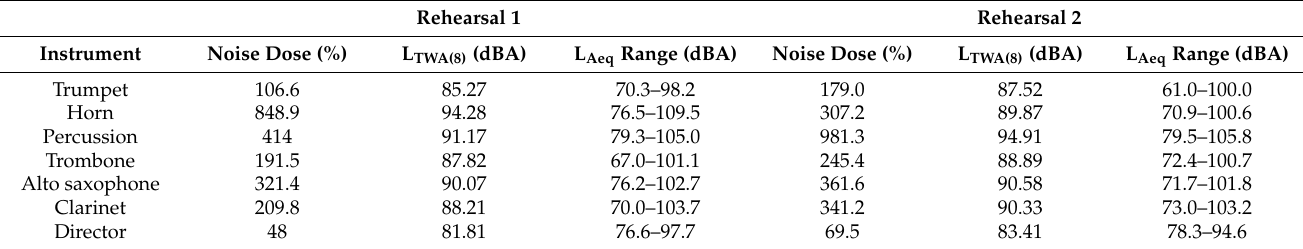
Table 1. Summarized data for noise dose, L Aeq range, and L TWA(8) of 6 marching band members and director during rehearsals.